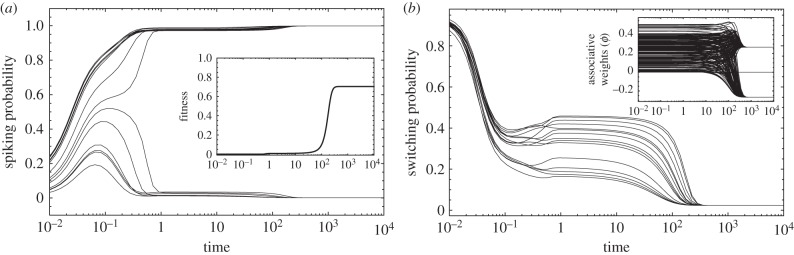
Neurodynamics in a stabilizing rugged landscape. Model parameters: T = 15; otherwise as in figure 2.